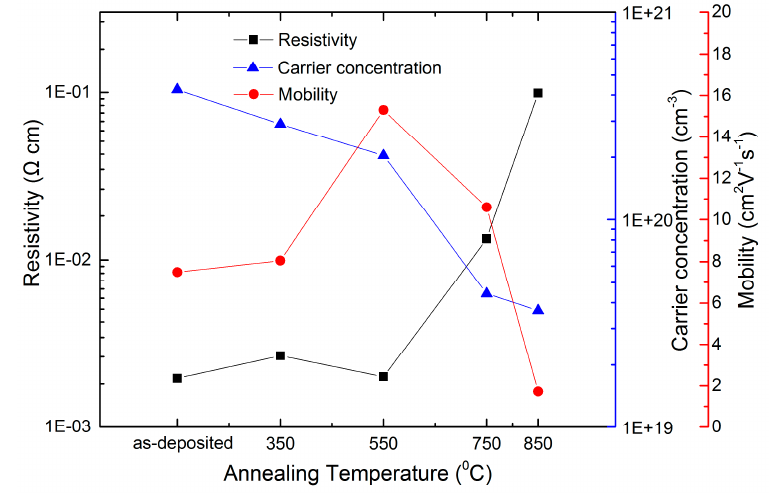
Figure 7. The resistivity, carrier concentration, and mobility of the ZnO:Zr films as a function of annealing temperature. annealing